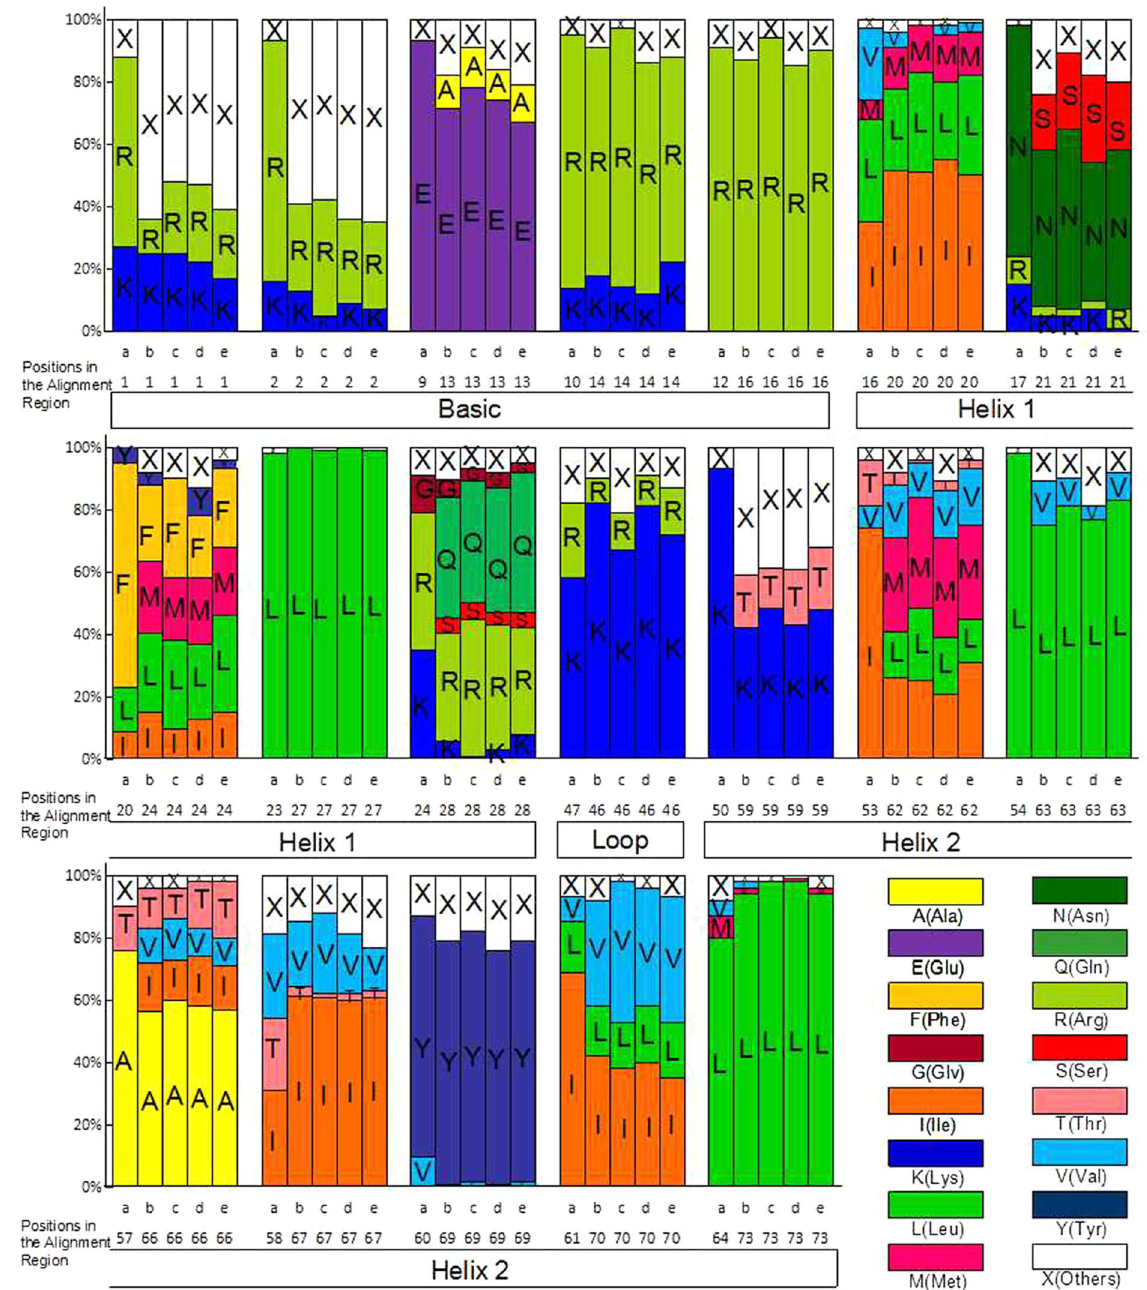
Figure 1. Amino acid distribution in the bHLH consensus motif. In columns labeled (a), percentage refers to the 392 animal bHLH proteins identified by Atchely et al. 2 . In columns labeled (b,d and e), percentage refers to the 158 AtbHLH genes, the 183 PtbHLH genes and the 173 OsbHLH genes, respectively, as reported by Carretero-Paulet et al. 28 . In columns labeled (c), percentage refers to the 175 MdbHLH genes identified in this current study. The numbers below (a,b,c,d and e) refer to the positions of the residues in the alignments of the